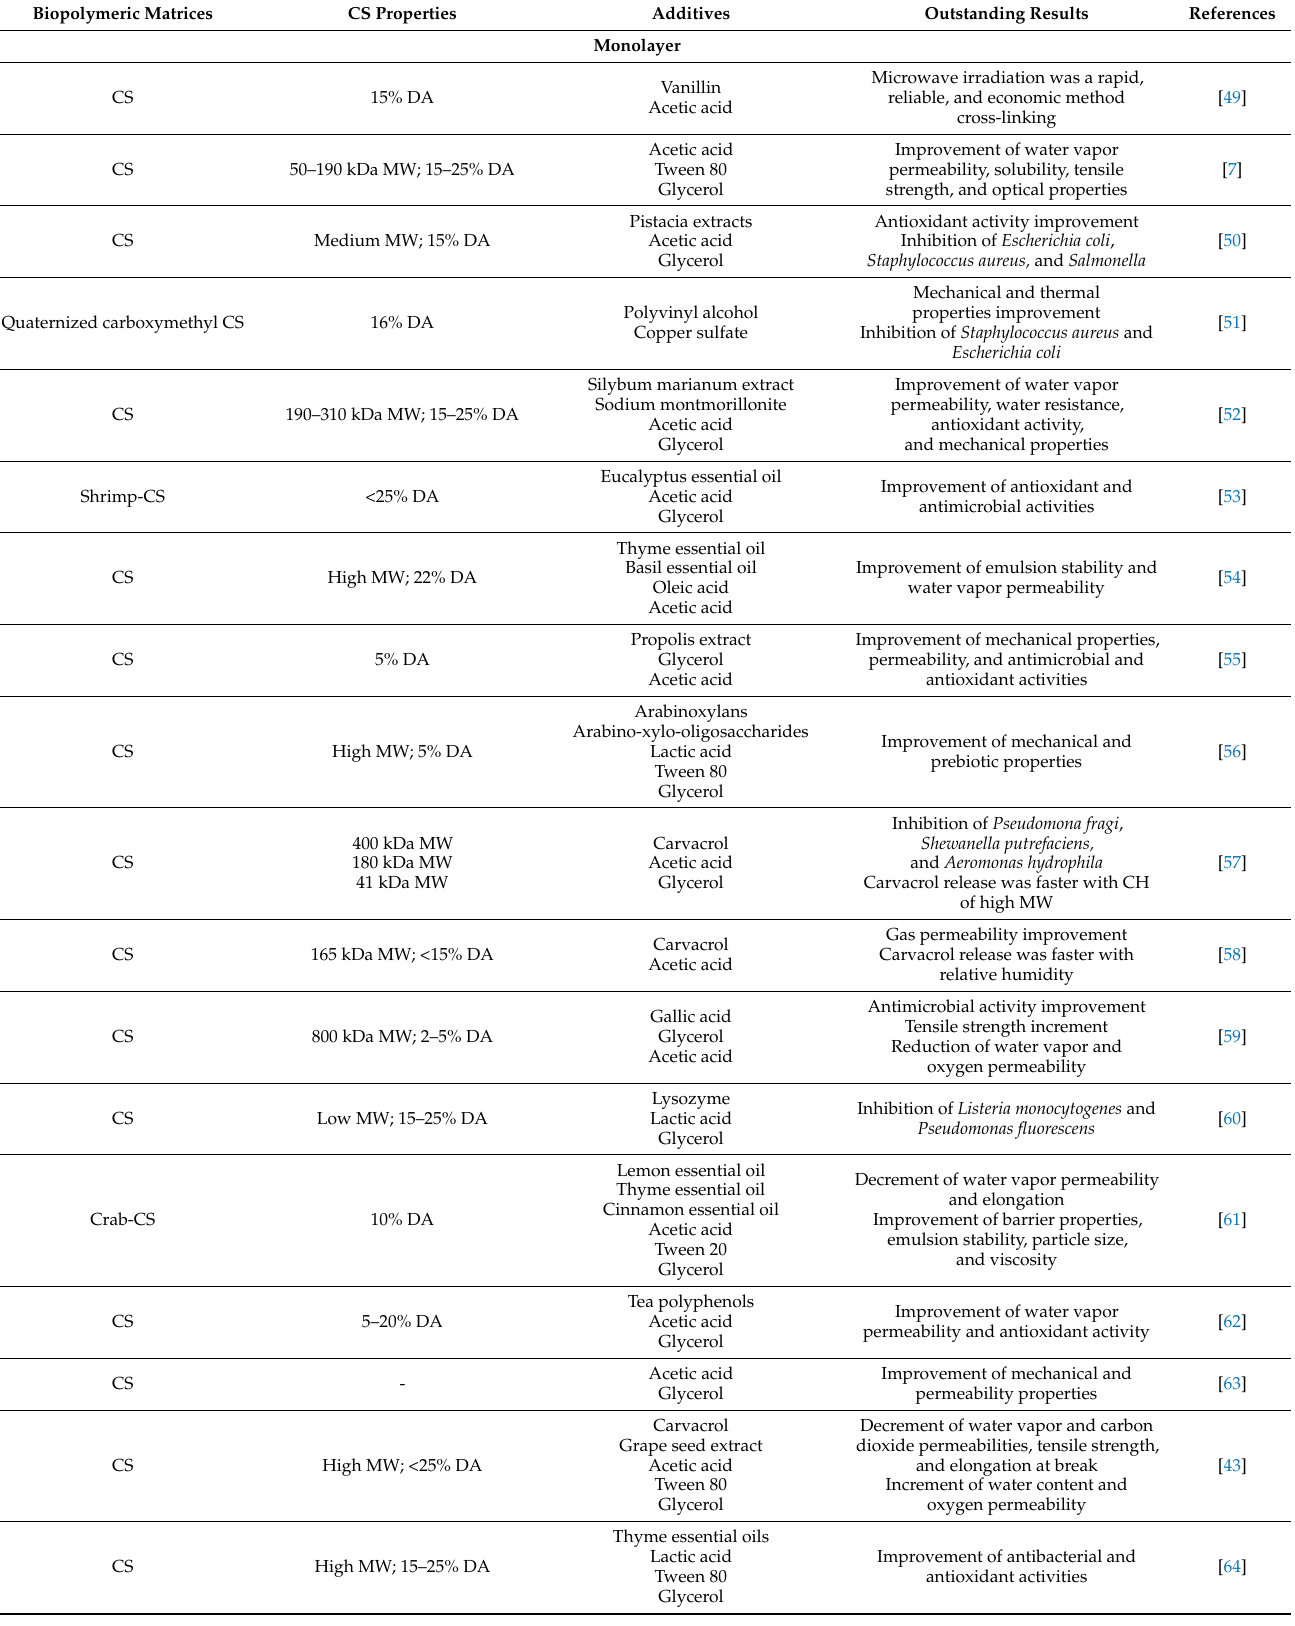
Table 3. Chitosan (CS)-based edible films and